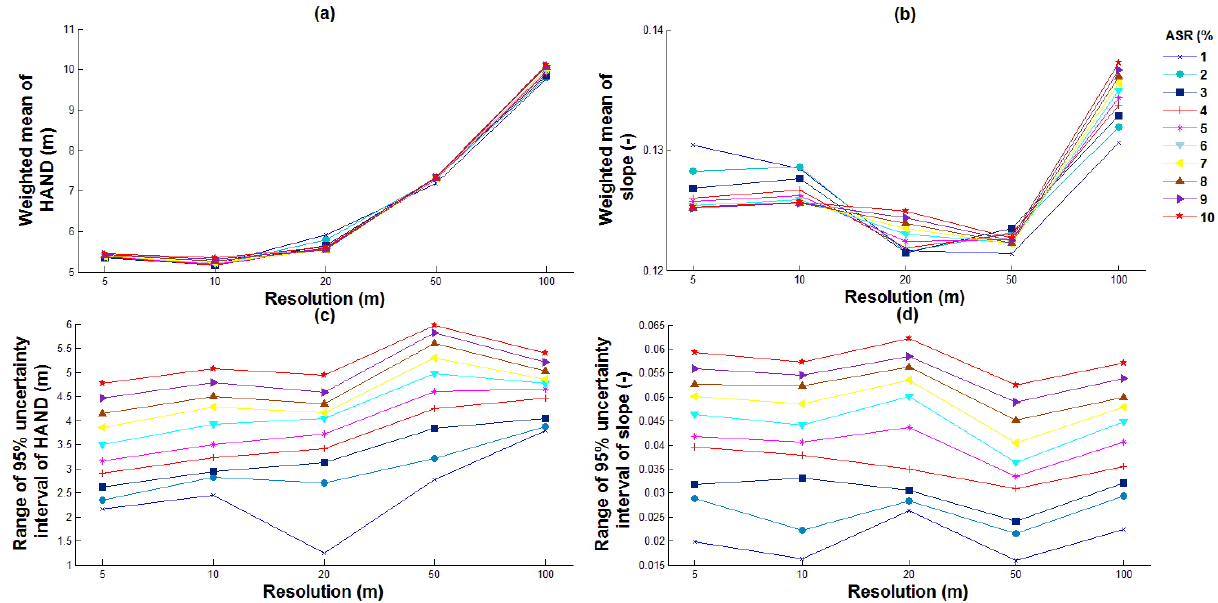
Fig. 9. (a) Likelihood weighted mean values of HAND for the modeling results retained as behavioral vs. different DEM resolutions for an acceptable sample rate (ASR) of 1–10%; (b) likelihood weighted mean values of slope for the modeling results retained as behavioral vs. different DEM resolutions for an acceptable sample rate (ASR) of 1–10%; (c) parameter range for 95% (2.5–97.5%) uncertainty interval of HAND for different resolutions (d) parameter range for 95% (2.5–97.5%) uncertainty interval for slope for different resolutions. Note that for comparative reasons and due to the inherent subjectivity in the choice of a threshold for defining behavioral parameter sets, the sensitivity of the parameter uncertainty ranges to varying thresholds is illustrated by showing the parameter ranges for best 1–10% of the acceptable sample rate (ASR).